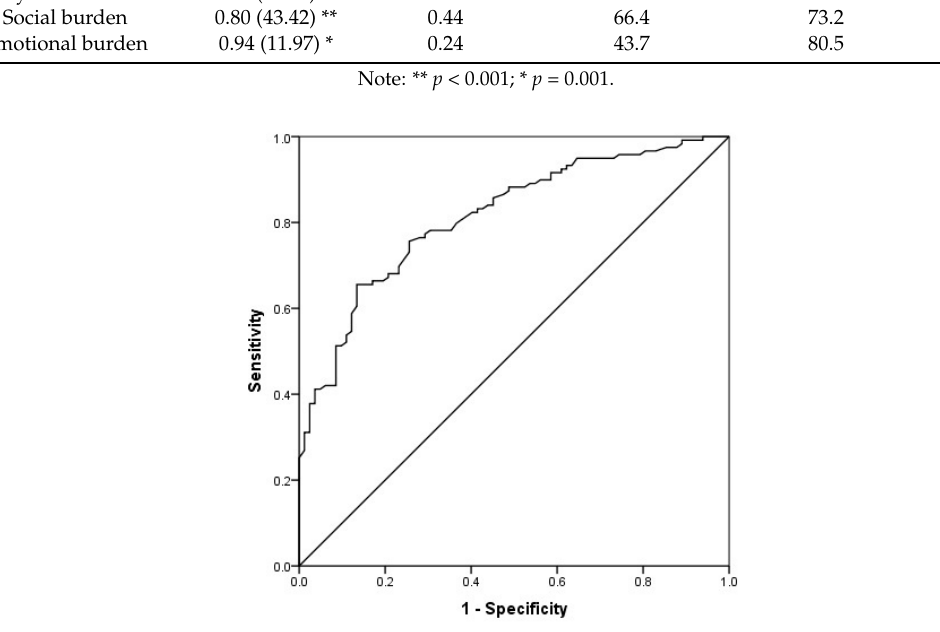
Figure 2. Receiver’s Operating Characteristics (ROC) Curve of the original CBI. Table 4. Predictive ability for the cut-off points of the original